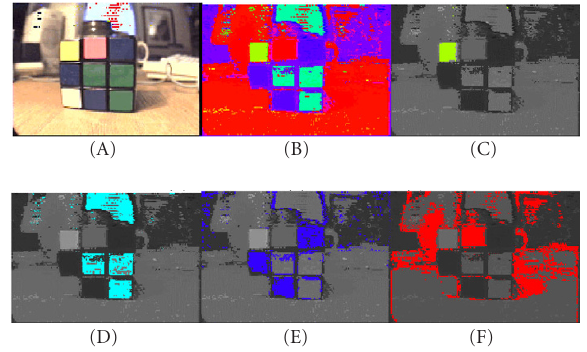
Figure 13: Color segmentation on real images. (a) Input image. (b) Complete Hue image. (c) Yellow segment. (d) Cyan segment. (e) Blue segment. (f) One of the red